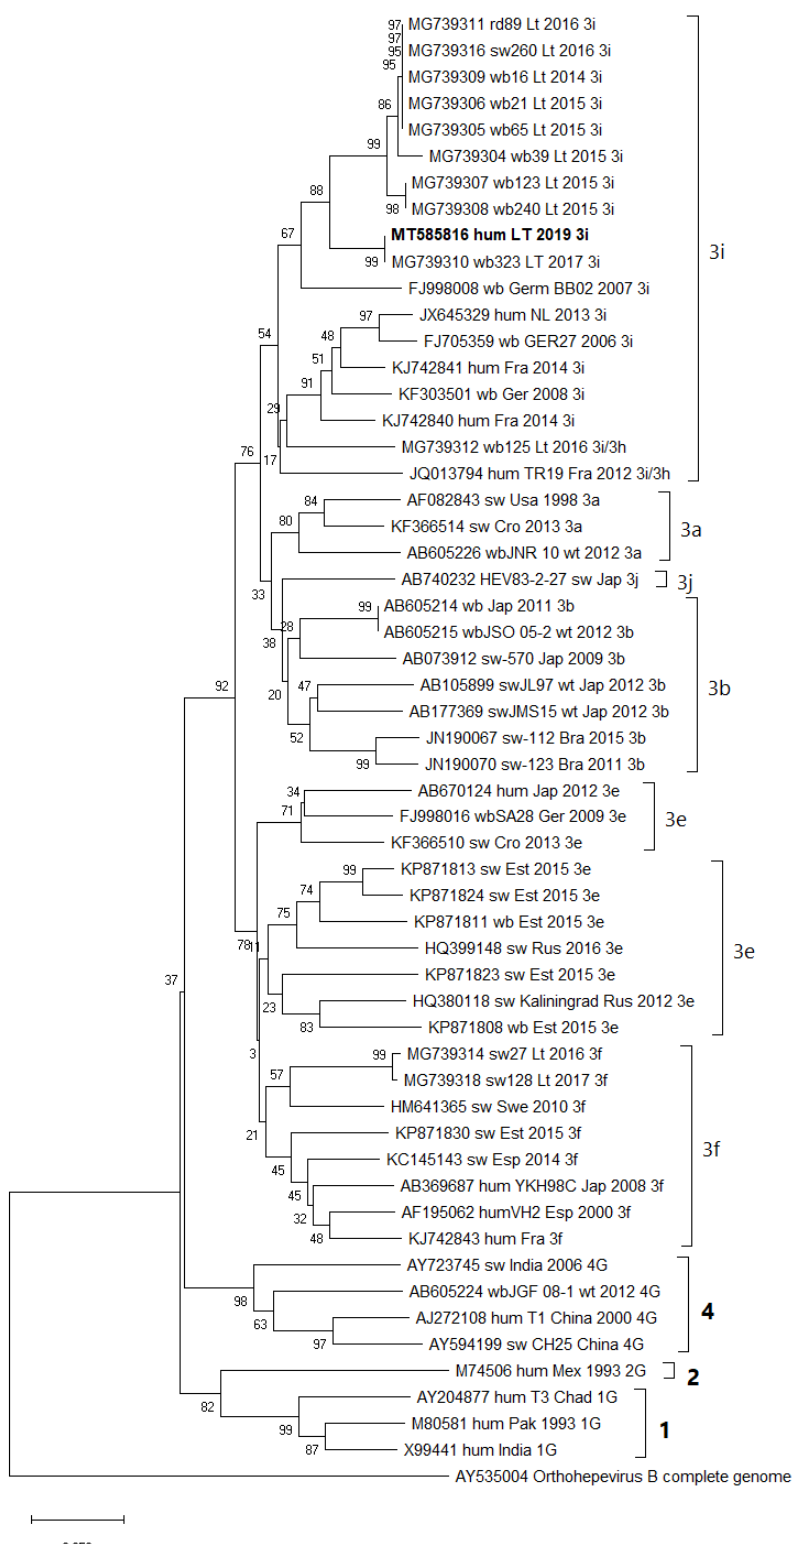
Figure 2. Phylogenetic analysis of partial HEV RNA sequence MT585816 from the human sample (highlighted in bold). Avian HEV (AY535004) was used as an outgroup.